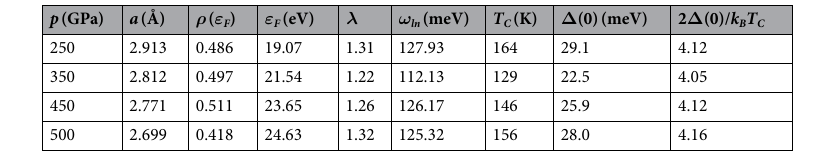
Table 1. Density of states at the Fermi level ρ ( ε F ) (in units states/eV/f.u.), Fermi energy ε F , electron-phonon coupling constant λ , logarithmic phonon frequency ω ln , critical temperature T C (determined using Eliashberg equations for µ = .